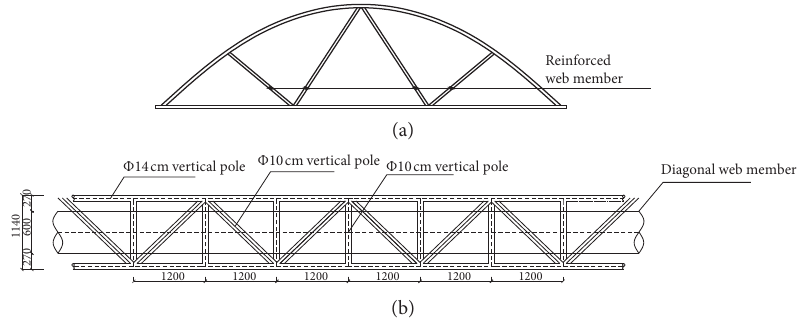
Figure 8: (a) Diagram of reinforcement location of webs. (b) Drawing of web reinforcement truss structure (unit: mm).